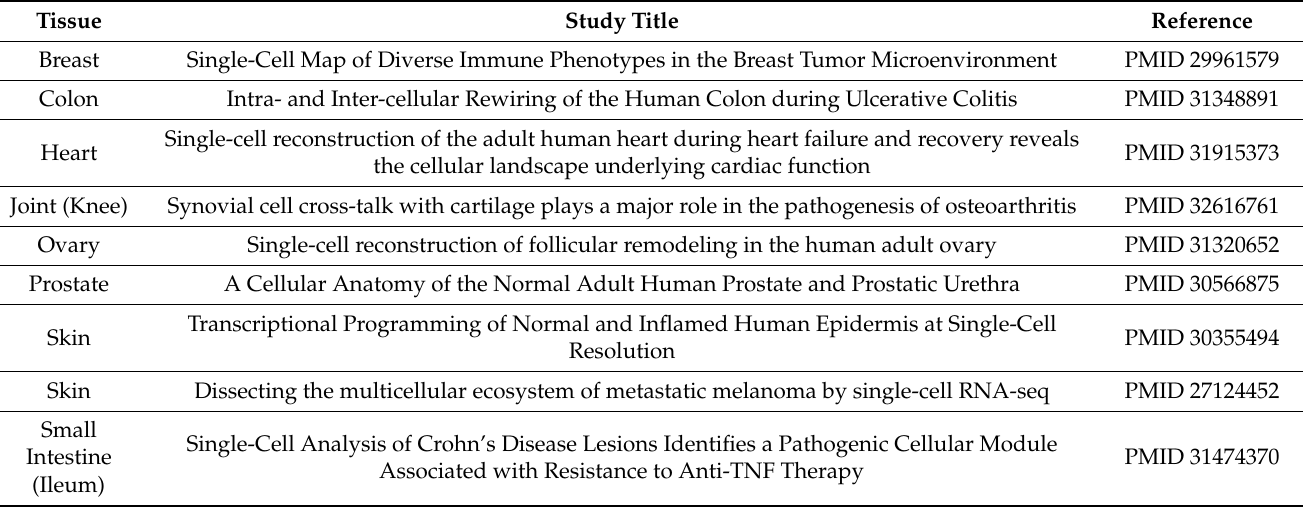
Table 2. List of human studies that were used to test the cluster annotation algorithm. The columns indicate (1) the tissue from which cells were derived in the study, (2) the title of the published study or dataset, and (3) the reference for the study